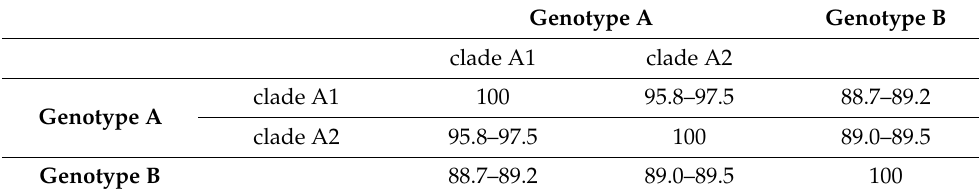
Figure 1. Unrooted phylogenetic tree based on the complete genomes of domestic cat hepadnavirus (DCH) viruses obtained in this study (HK01–HK12, black arrows) and reference strains retrieved from the GenBank database. Phylogeny was carried out using the Maximum Likelihood method and Hasegawa-Kishino-Yano model (two parameters), with a gamma distribution and invariable sites. The robustness of the individual nodes on the phylogenetic tree was estimated using 1000 bootstrap replicates. Bootstrap values greater than 70% are indicated. The subdivision in genotypes A and B, and clades A1 and A2 within genotype A are indicated. The scale bars indicate the estimated number of nucleotide substitutions per site. Table 4. Nucleotide identity between domestic cat hepadnavirus (DCH) Genotypes and Clades based on the overall